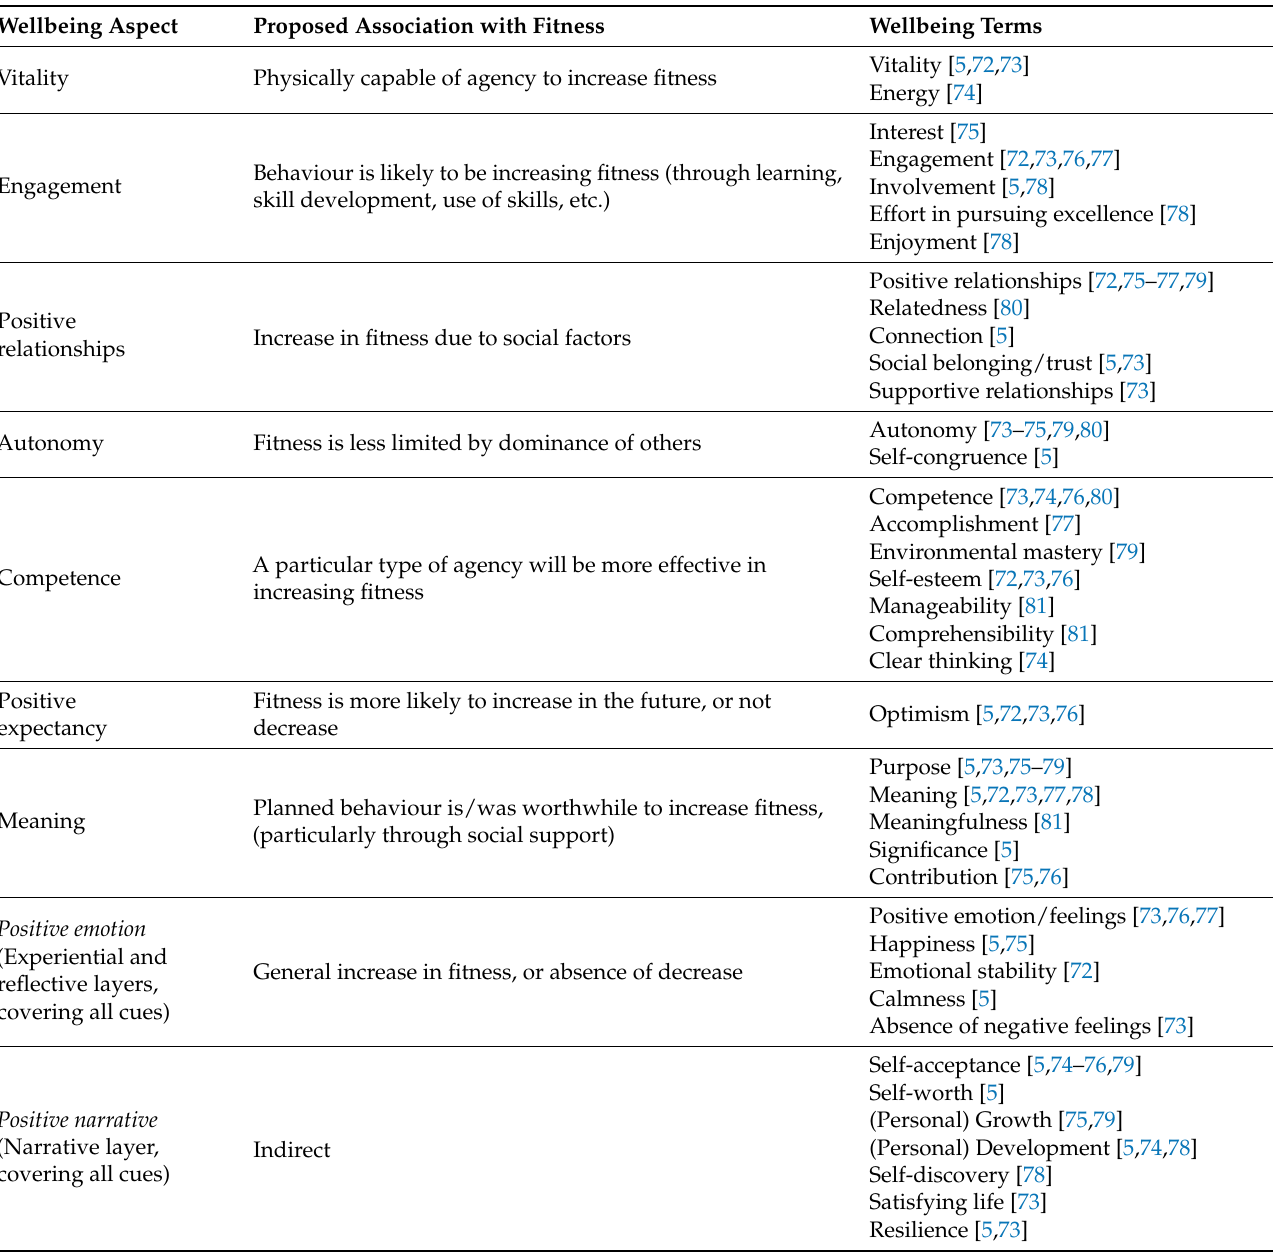
Table 2. Proposed associations between wellbeing constituents and fitness by wellbeing